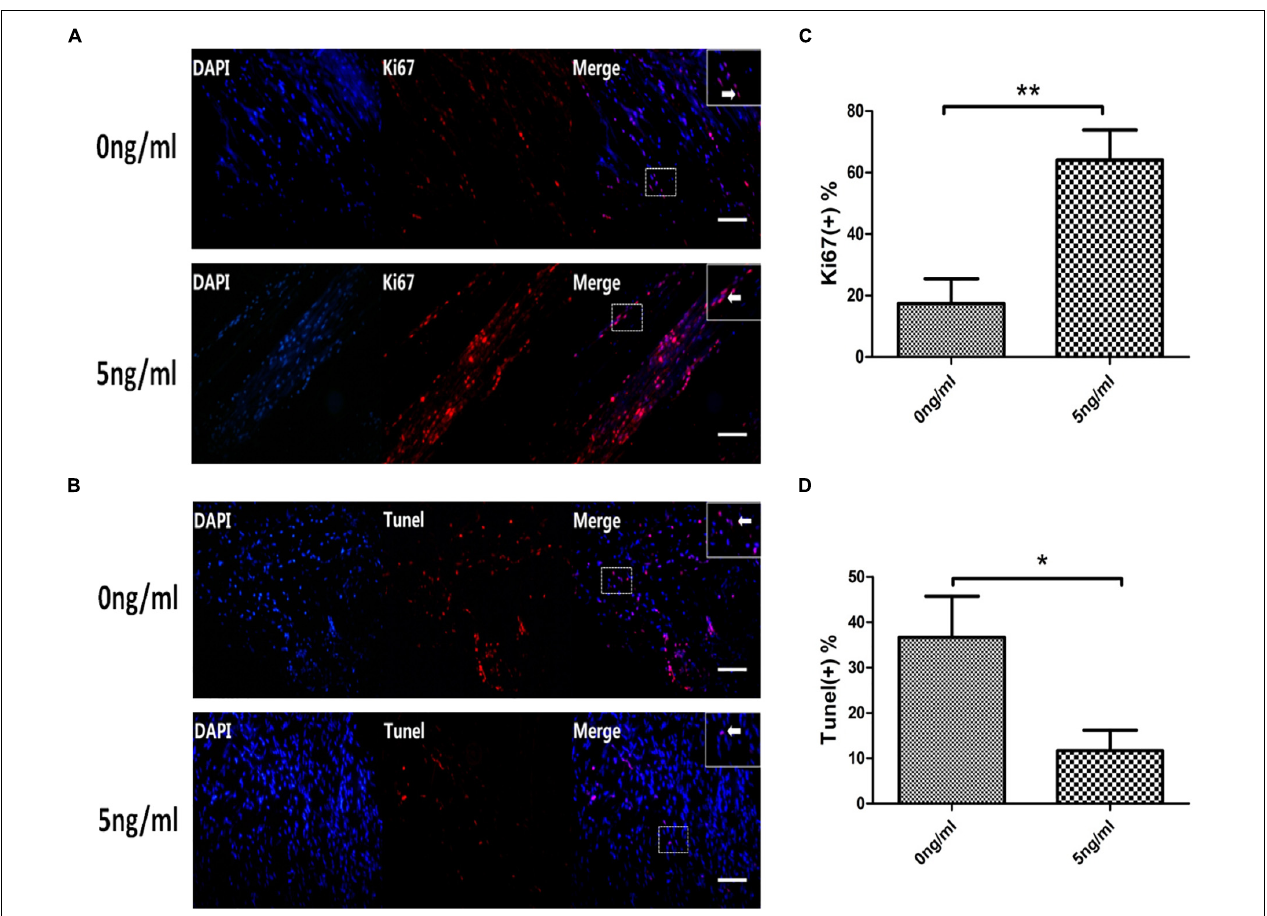
FIGURE 5 | Expression of Ki67 and TUNEL in the in vitro WD model. Immunofluorescent staining of Ki67 (A , arrows indicate Ki67( + ) cells ) , analysis of percentage of endonuclear Ki67( + ) cells (C) in SCs with or without 5 ng/ml IL-1 β at 48 h. TUNEL staining of apoptosis cells ( B , arrows indicate apoptosis cells),analysis of percentage of TUNEL( + ) cells (D) in SCs in the in vitro WD model with or without 5 ng/ml IL-1 β at 48 h. Results are means ± SE ( n = 3 per group) from independent experiments. ∗ p < 0.05, ∗∗ p <